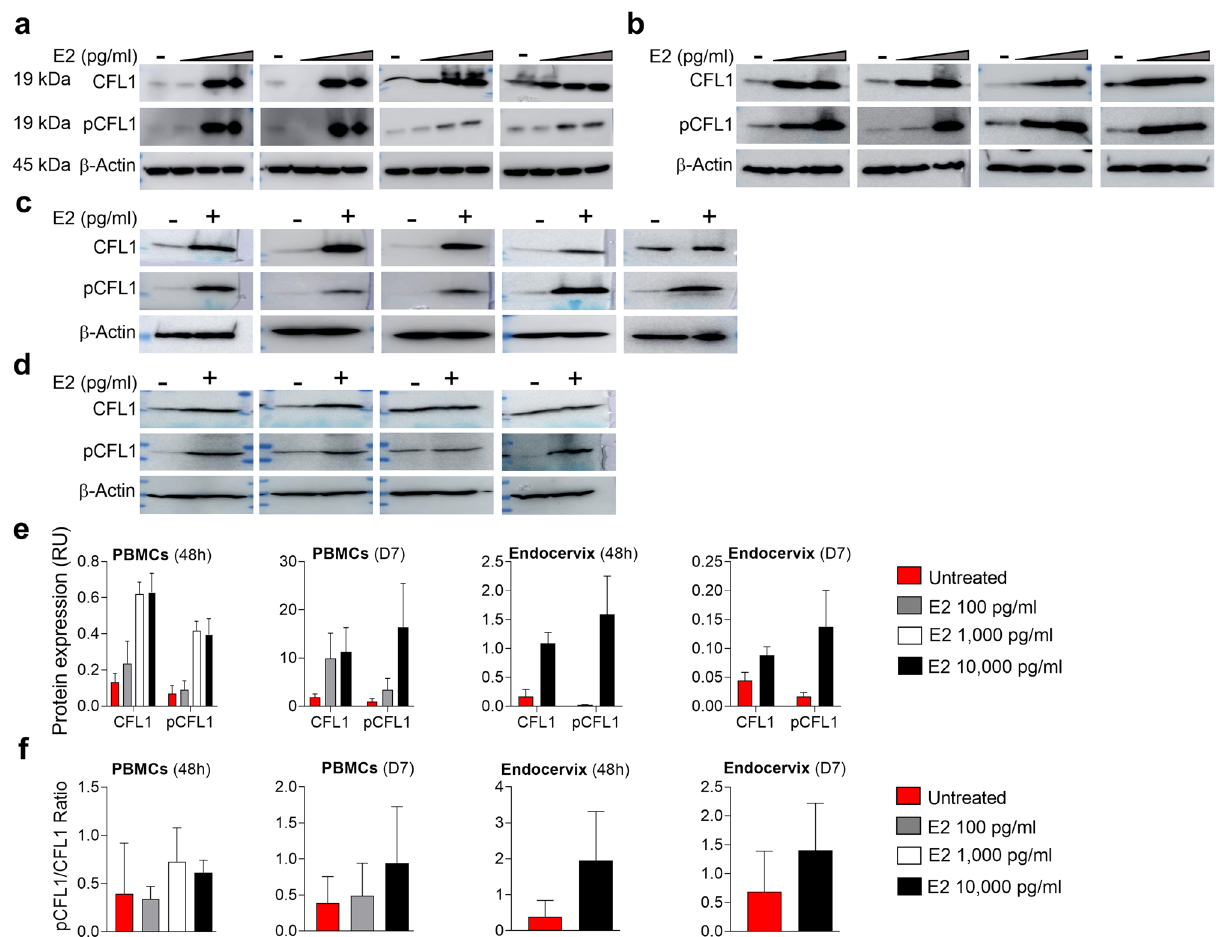
Figure 6. E2 induces total CFL1 and pCFL1 expression in PBMCs and endocervix and increases pCFL1/ CFL1 ratio. PBMCs were (a) incubated with E2 100, 1000, 10,000 pg/ml (vs. untreated control) for 48 h (4 experiments) or (b) incubated with E2 100 or 10,000 pg/ml, challenged with 1000 TCID 50 /10 6 cells HIV-1 BaL and cultured for 7 days (4 experiments). WCEs (60 µg) were probed for CFL1 and pCFL1. β-actin (60 µg) was used as internal control. (c) Endocervical explants were incubated with E2 10,000 pg/ml (vs. untreated control) for 48 h (5 experiments) or (d) incubated with E2 10,000 pg/ml (vs. untreated control), challenged with 500 TCID 50 HIV-1 BaL and cultured for 7 days (4 experiments). WCEs (60–120 µg) were probed for CFL1 and pCFL1. β-actin (60–120 µg) was used as internal control. (e) Expression of CFL1 and pCFL1 in experiments presented in ( a – d ) was normalized relative to β-actin expression and plotted; and (f) pCFL1/CFL1 ratios were calculated and plotted. Shown are Mean ± SEM. For each experiment, CFL1, pCFL1 and β-actin blots were developed in parallel. Uncropped blots are presented in Supplementary Fig.